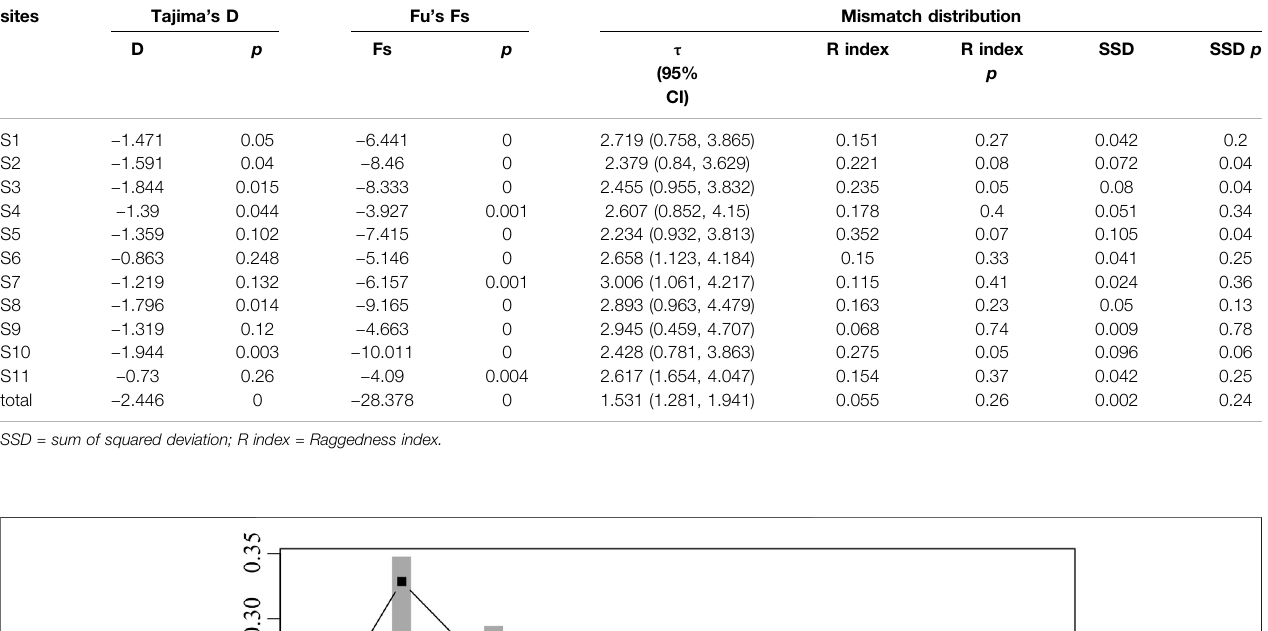
( Table 2 ). The effective number of migrants per generation among sampling sites ranged from 5.98 to 45.76. The rates of migration from S7 to S1 were the lowest, whereas those from S1 to S3 were the highest ( Table 3 ).